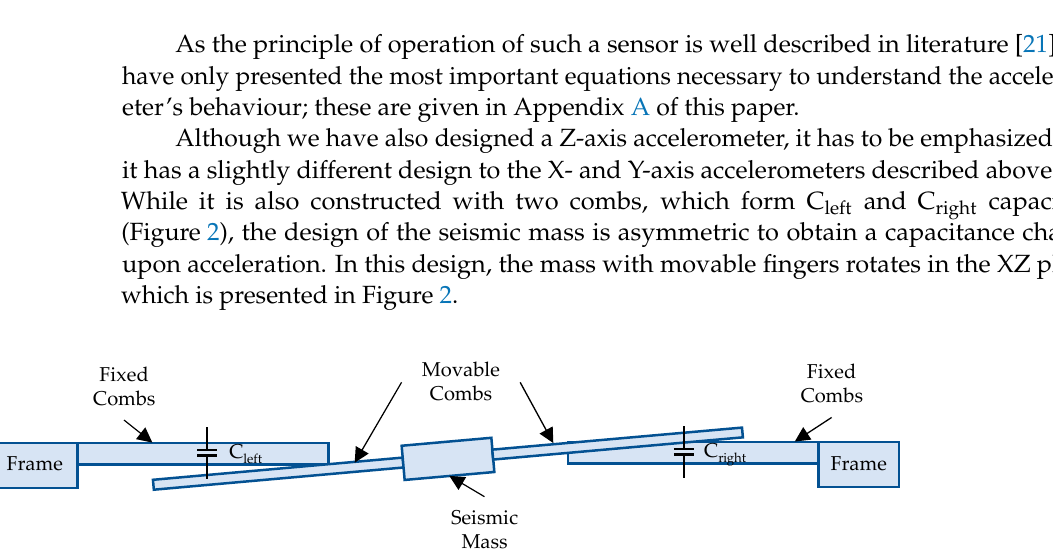
Figure 2. The operation principle of the capacitive accelerometer in the Z axis (rotation not to scale). Two types of fingers are used in this design: normal fingers, as fixed combs, and thinned fingers (with reduced height), as movable combs. When acceleration is applied, only one